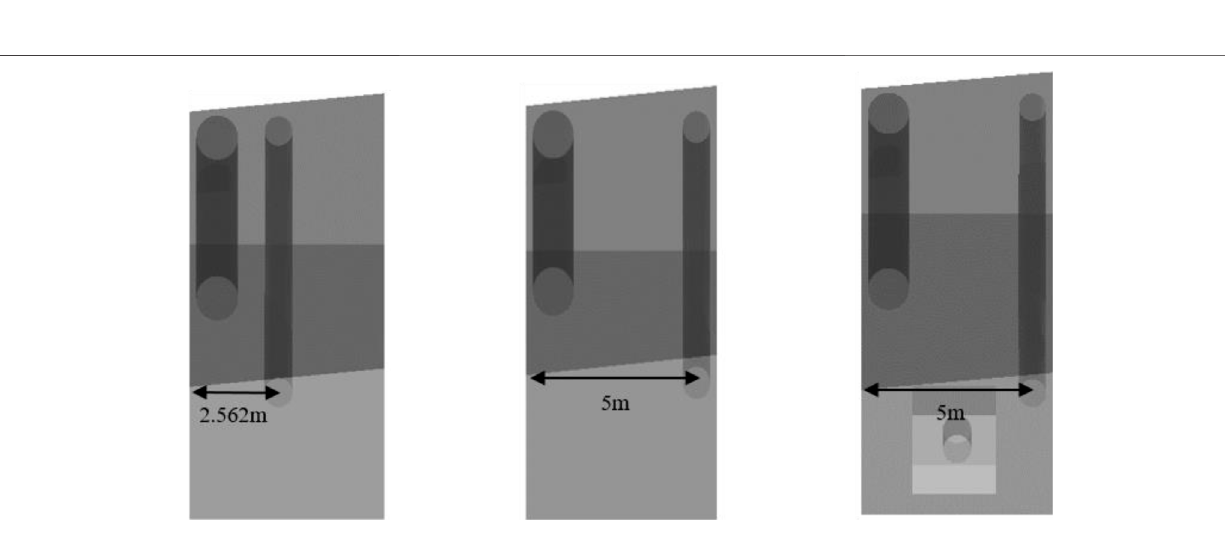
Frontiers in Earth Science |